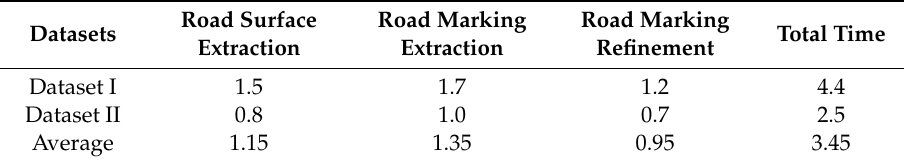
Table 3. Running time for each step (unit: